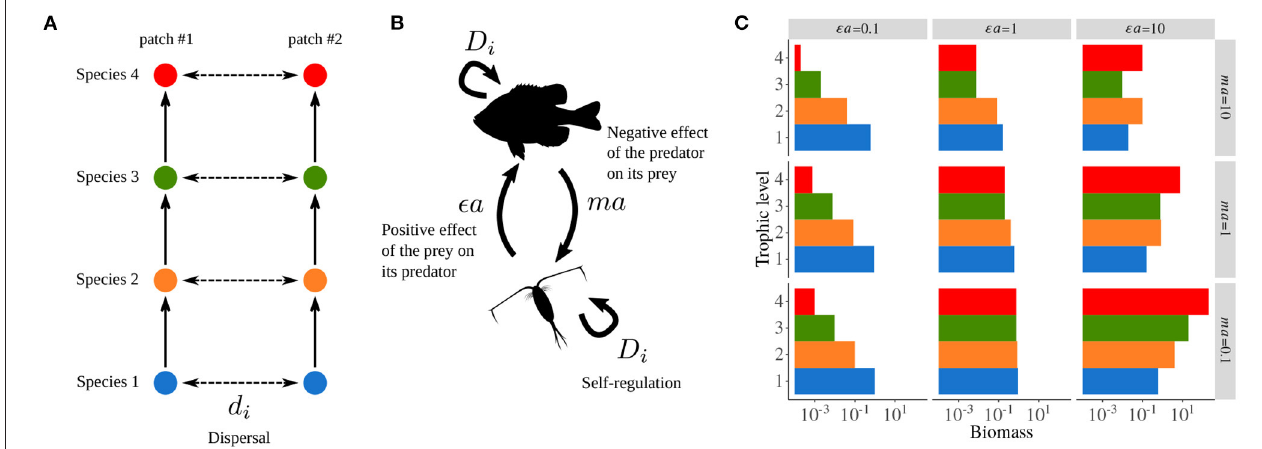
FIGURE 2 | General description of the metacommunity model. (A) Metacommunity model with two patches, each sustaining a food chain with the same species whose populations are linked by dispersal. (B) Food web model: ε a the positive effect of the prey on its predator and ma the negative effect of the predator on its prey. D i is self-regulation, which represents negative intra-specific interactions (e.g., disease and territoriality). (C) Biomass distribution in an isolated food chain depending on ε a and ma ( g 1, r 0, ε 0.65, D 1, d i 0). Adapted from Quévreux et al. (2021a). = = = = =